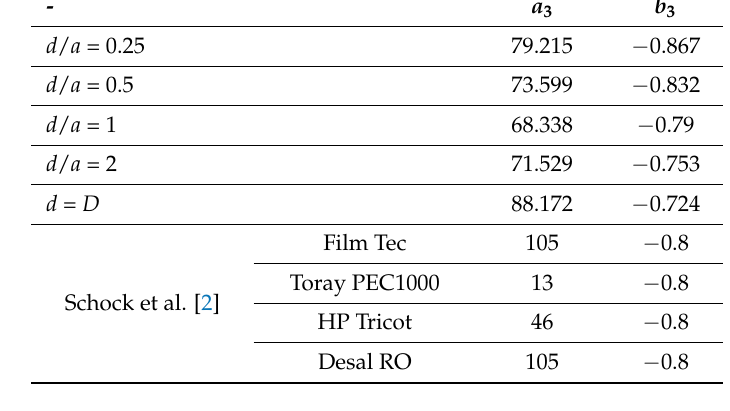
Figure 9. The friction factor, associated with the connecting filament diameter, as a function of the Reynolds number. A comparison was made with the friction factor results of Haaksman et al. [23]. Table 2. The friction factor function parameters.